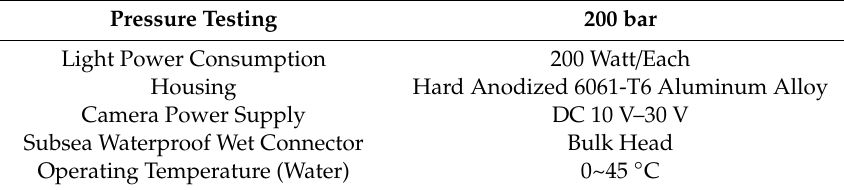
Table 8. Specification table for portable lux meter HI97500.